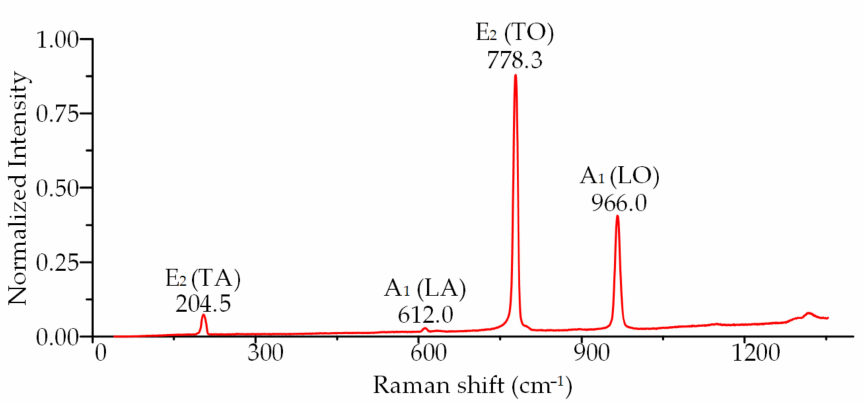
Figure 3. Typical backscattering Raman spectra of 4H-SiC.